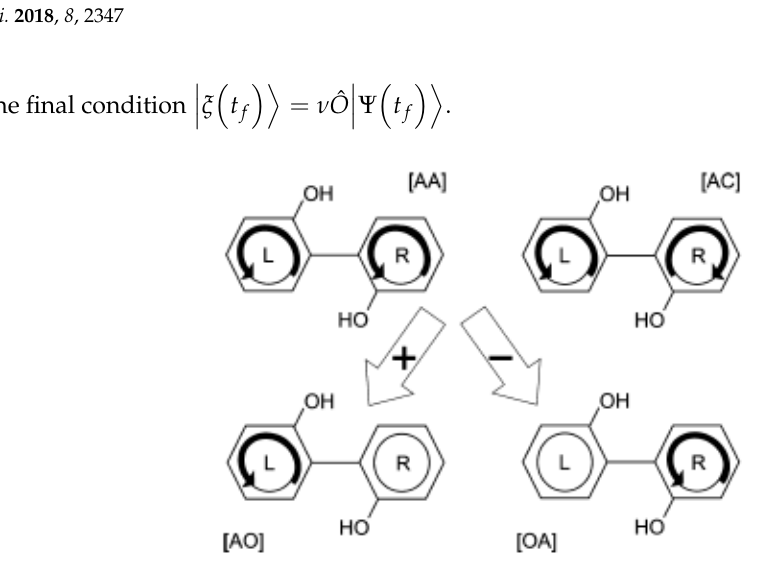
Figure 14. Superposition of coherent π -electron rotation patterns. The arrow with positive (negative) sign specifies an in-phase (out-of-phase) superposition of [AA] and [AC] rotation patterns. The in-phase superposition creates [AO] rotation pattern, which means anticlockwise rotation localized on the L ring with no rotation on the R ring, while the out-of-phase superposition creates [OA] rotation pattern. Here, O means no rotation. Reprinted from [91] with permission of the American Chemical Society.